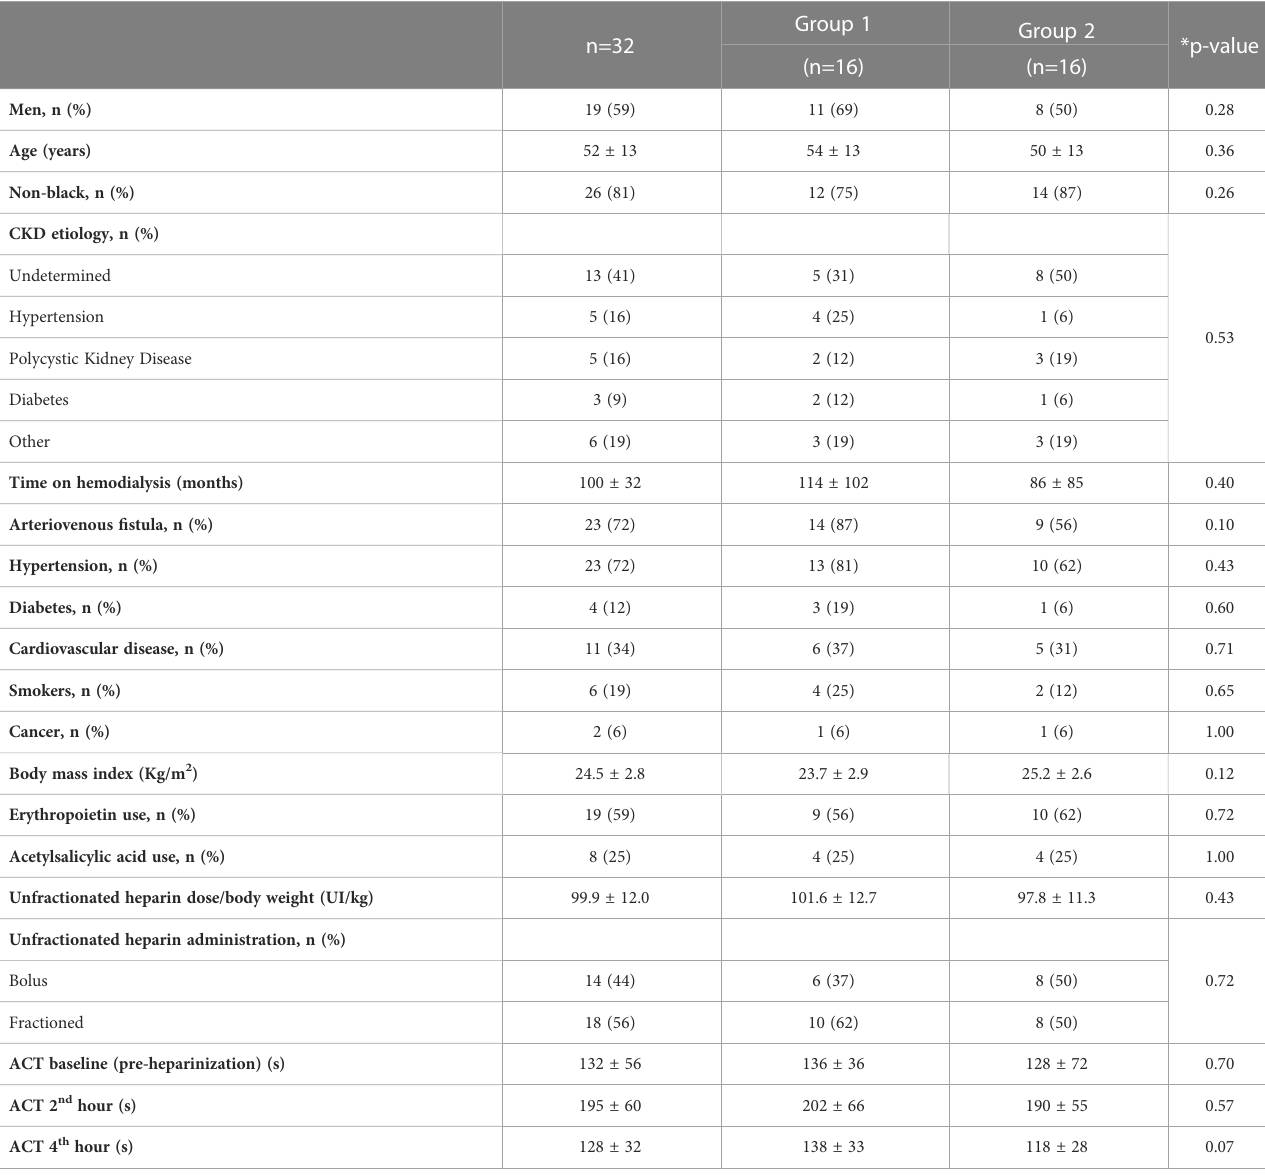
TABLE 1 Characteristics of the studied population.